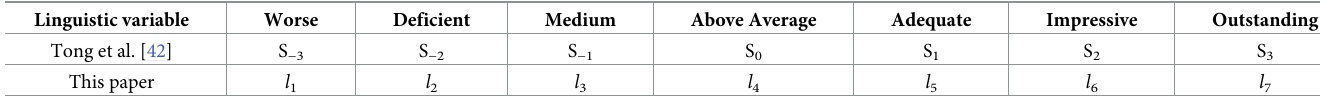
Table 19. Linguistic terms and corresponding degree in PLTS in two papers.